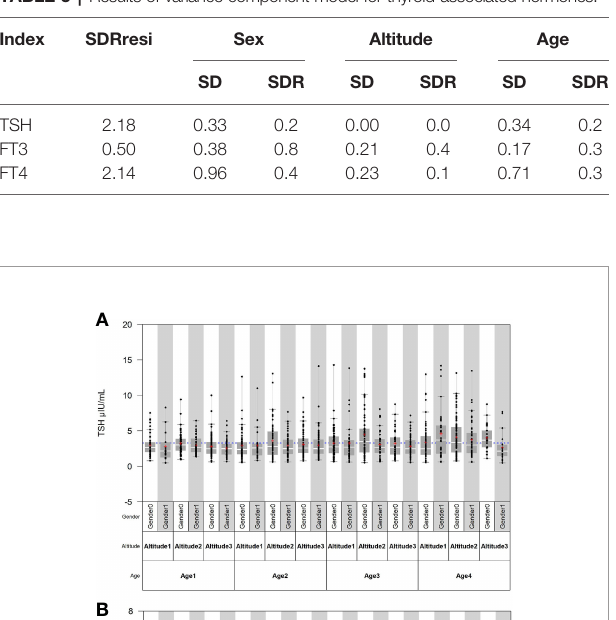
sex- and altitude-speci fi c RIs for FT3 should be considered when the SDR ≥ 0.4. The RIs for FT4 should be partitioned by sex with SDRsex of 0.4.